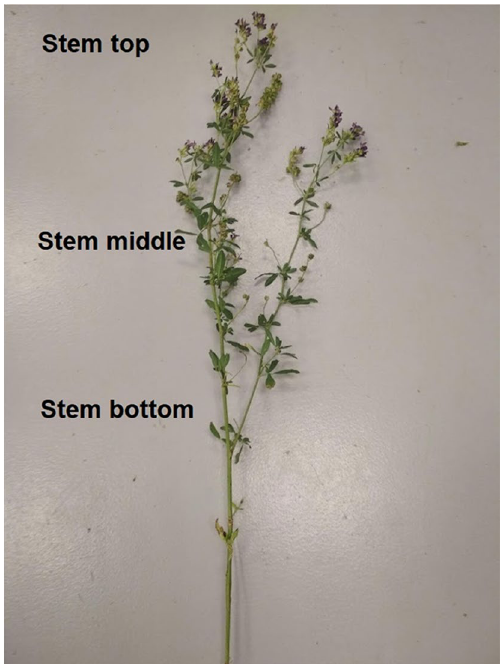
Figure 5. Parts of the stem from which leaves were collected for testing. Photo by Agata